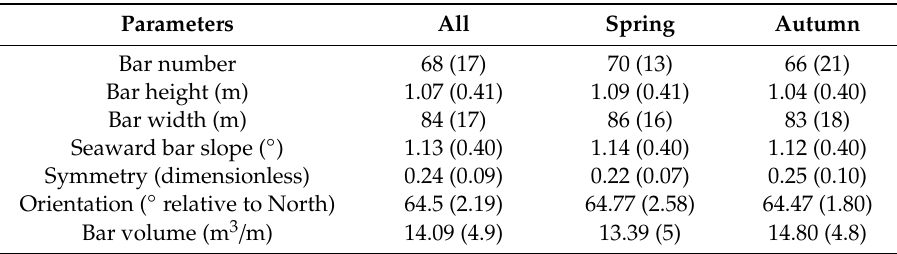
Table 3. Bar morphometric parameters of the bar morphology from 2013 to 2019. Columns present the average of annual, spring, and autumn characteristics. Values in brackets correspond to the standard